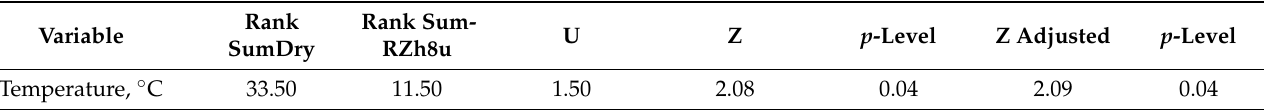
Table 6. Mann–Whitney U-test for the significance of the division into the groups “dry surface”- “lubricant RZh8u”.